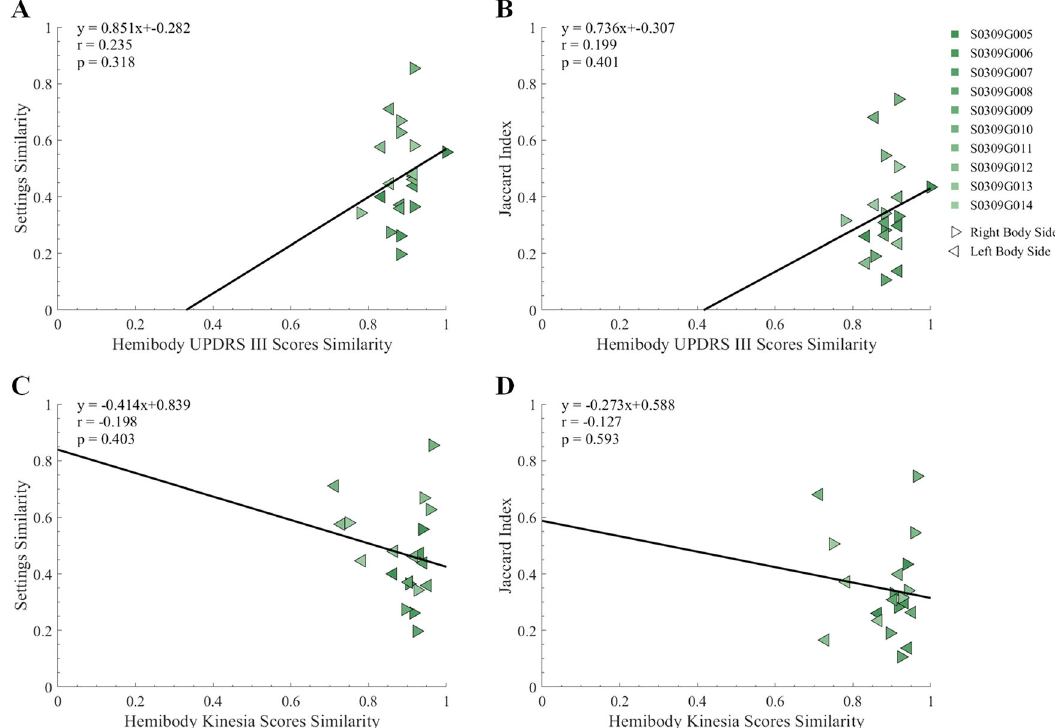
Fig. 4 Non-signi fi cant correlation of similarities between SoC and AgP clinical effects and their DBS settings. Correlation of A settings similarity and B VTA Jaccard index with hemibody UPDRS III scores similarity ( n = 20). Correlation of C settings similarity and D VTA Jaccard index with hemibody Kinesia ™ One scores similarity ( n =